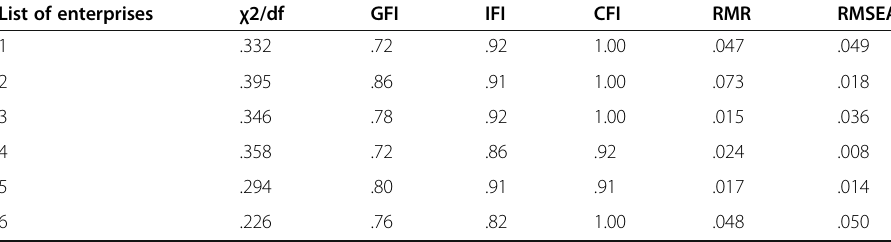
Table 1 Goodness-of-fit